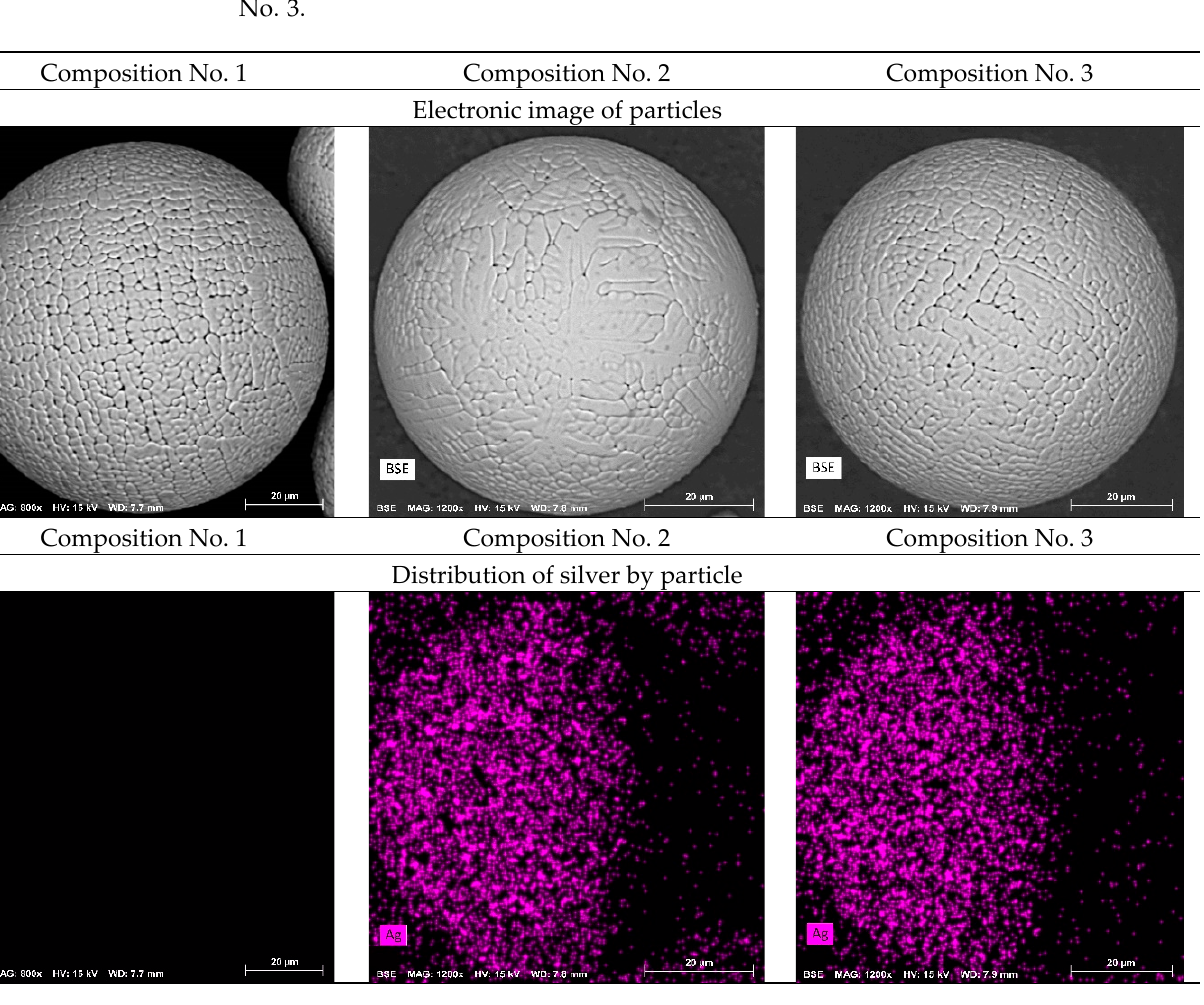
Figure 4. SEM images of powder particles and the distribution of silver on the surface (No. 1—316L; No. 2—316L +0.2 wt.% Ag; No. 3—316L +0.5 wt.% Ag).